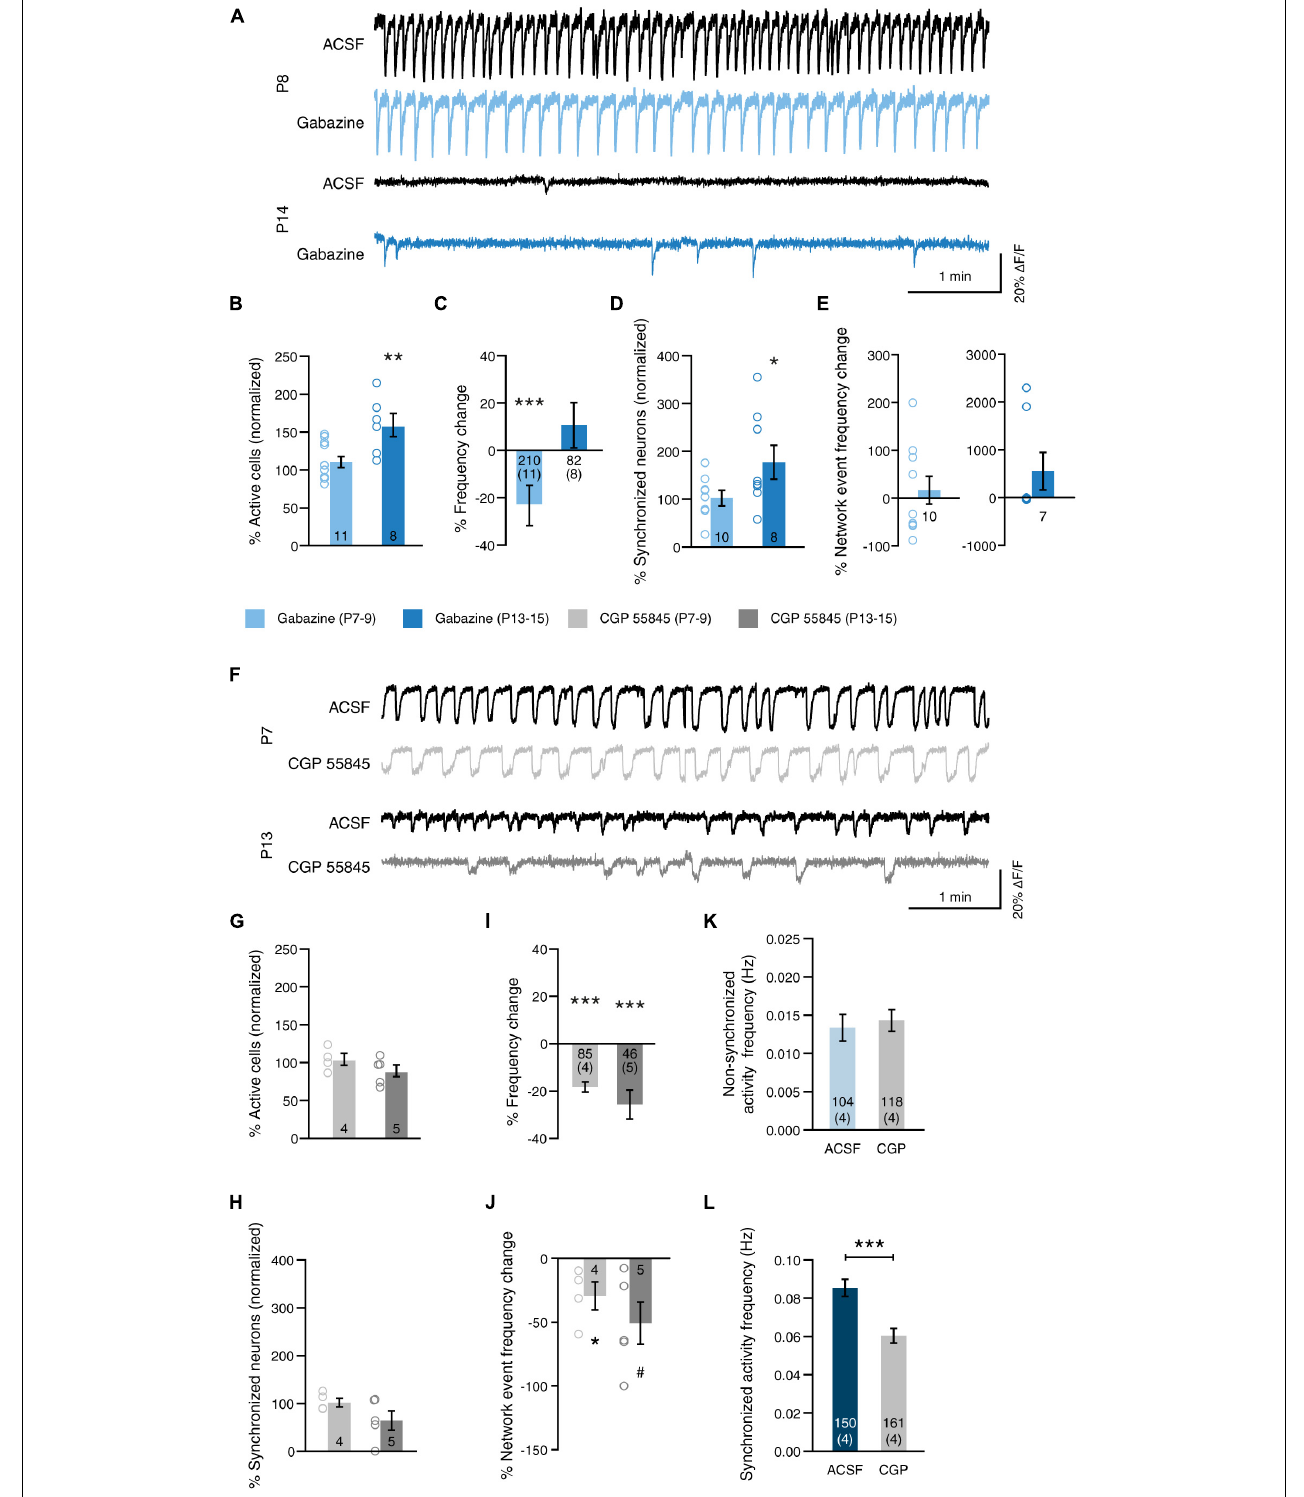
FIGURE 5 | GABA modulates network activity in a receptor-type-dependent manner. (A) Example traces before (ACSF, black) and after blockade of GABA-A receptors (Gabazine, blue) at P8 and at P14. (B) Blockade of GABA-A receptors at 2 weeks (P13–15) increased the proportion of active cells [gabazine 2 weeks: